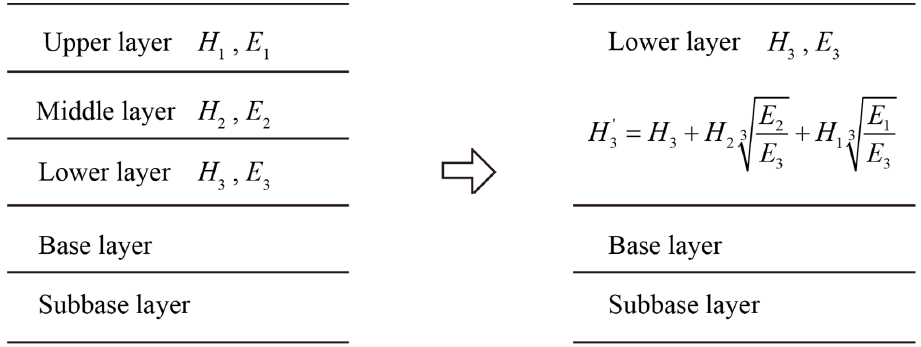
Figure 12. Schematic diagram of pavement structure and equivalent layer thickness conversion.